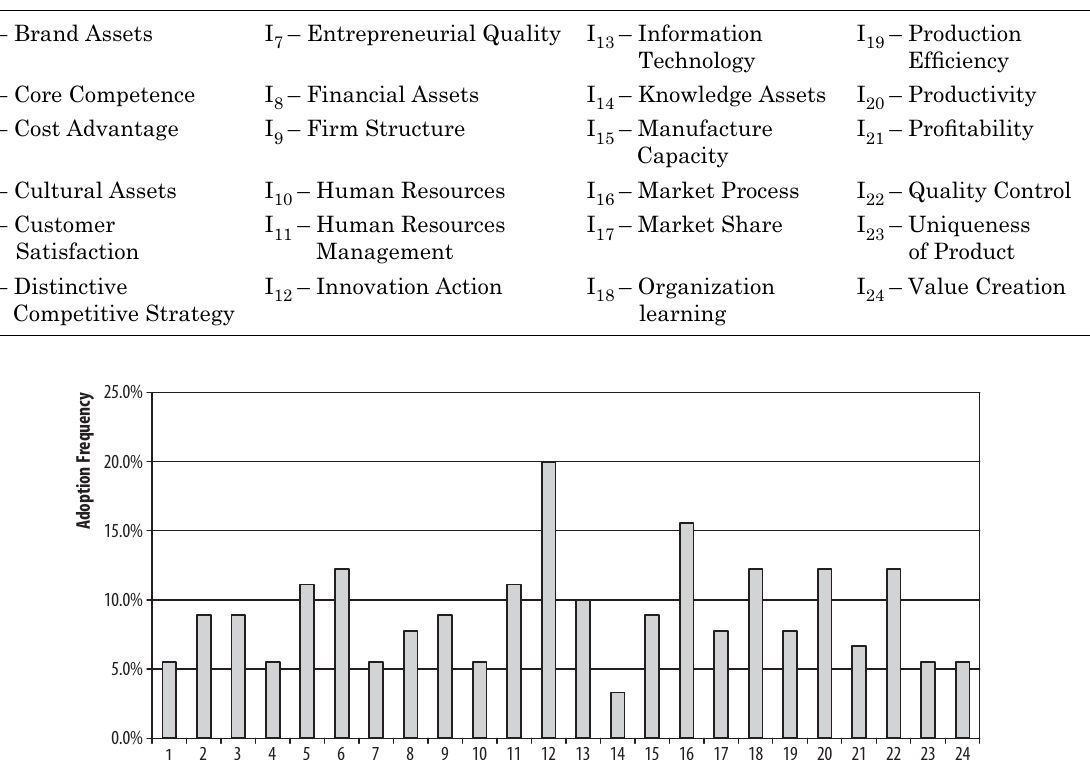
Table 1. Typical indicator for measuring organization competitiveness